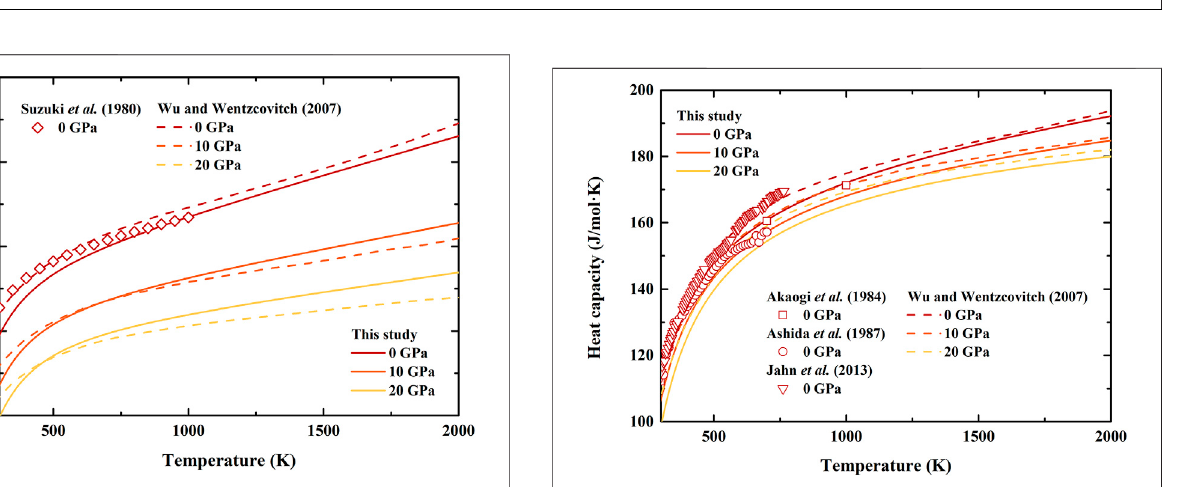
(Mg 0.87 Fe 0.13 ) 2 SiO 4 as a function of temperature at various pressures are illustrated in Figures 3 – 5 , respectively. Since there is no thermodynamic data of Fe-bearing wadsleyite at